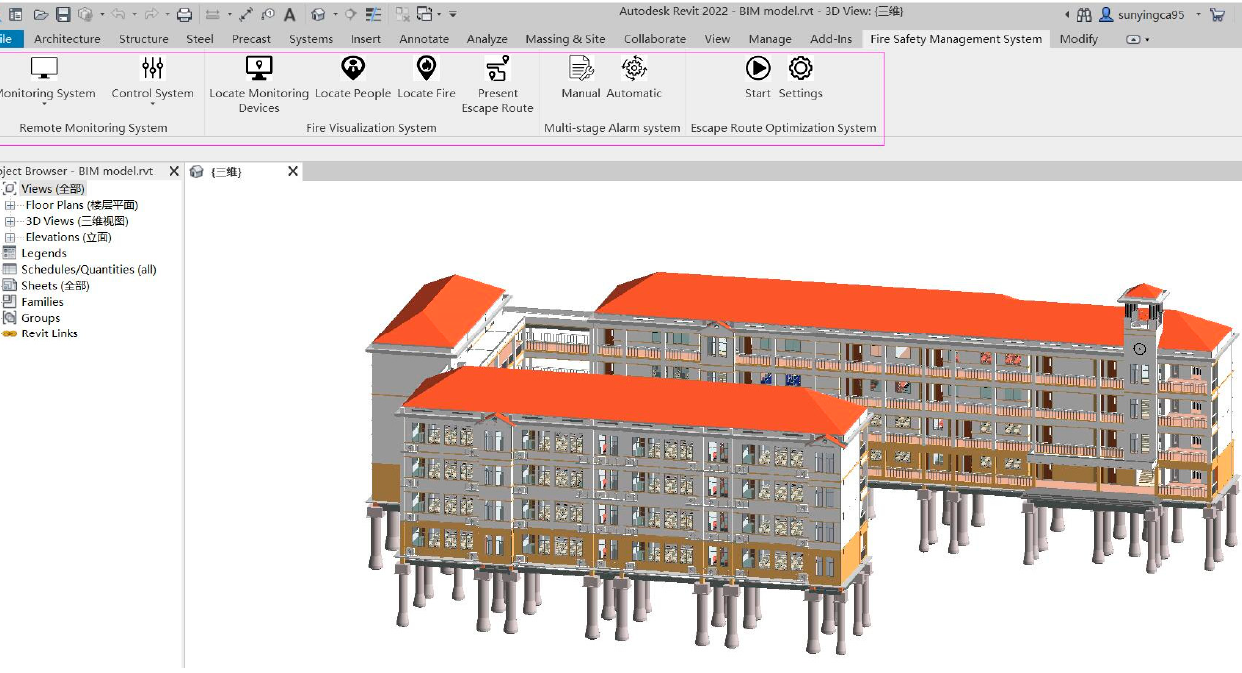
Figure 1. Revit add-ins of subsystems.